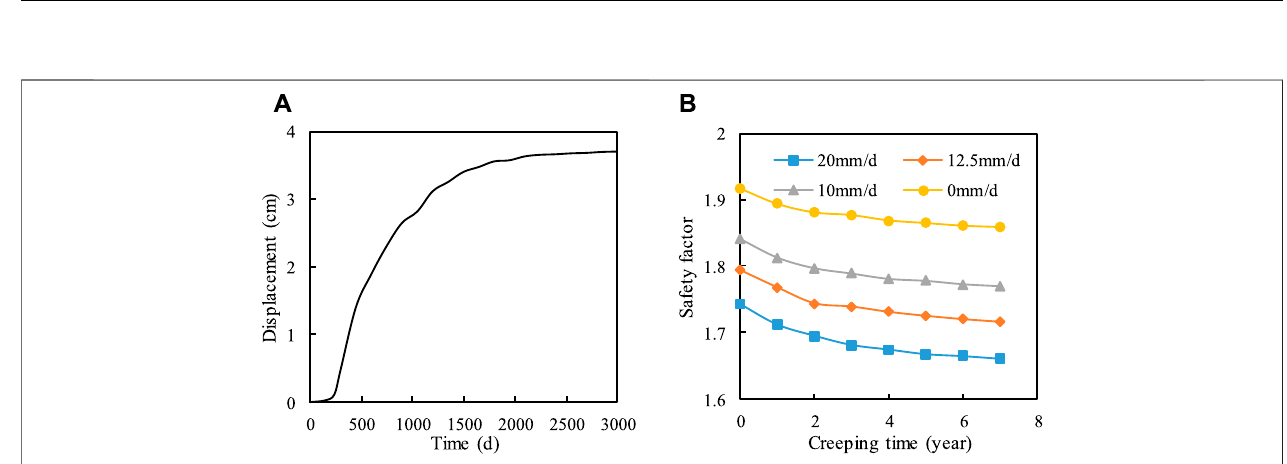
FIGURE 13 | Changes of (A) displacement of the slope foot and (B) safety factor of expansive soil slope.